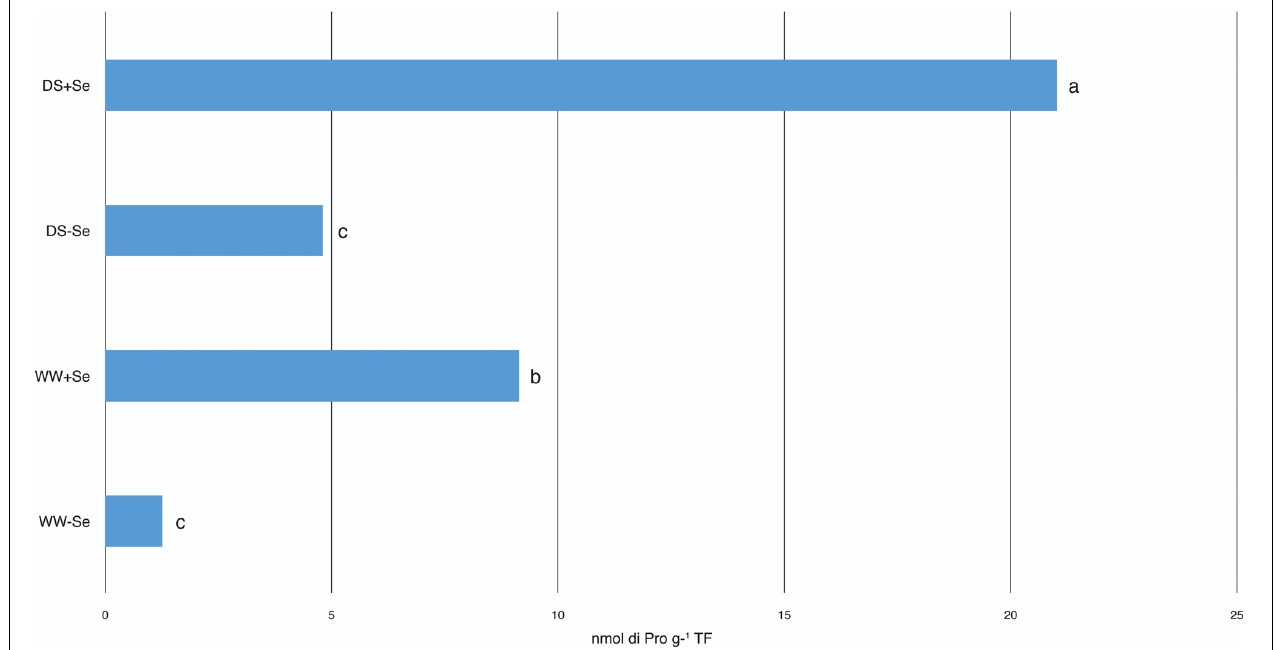
FIGURE 1 | Proline (Pro) concentrations in aerial parts. WW, well watered; DS, drought stress. (WW–Se) normal irrigation without Se treatment, (DS–Se) drought stress without Se treatment, (WW+Se) normal irrigation with Se treatment and (DS+Se) Se under drought stress conditions. Data for each experiment were compared separately using Fisher’s LSD test ( P < 0.05). Different letters indicate significant differences between